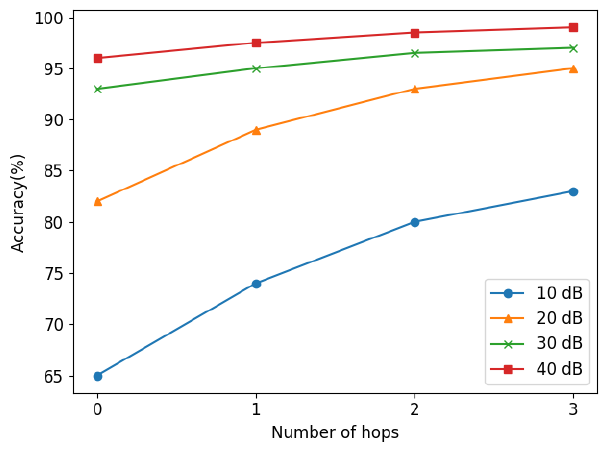
Figure 10. Fault location results with different noise. Table 3. Comparison results with different